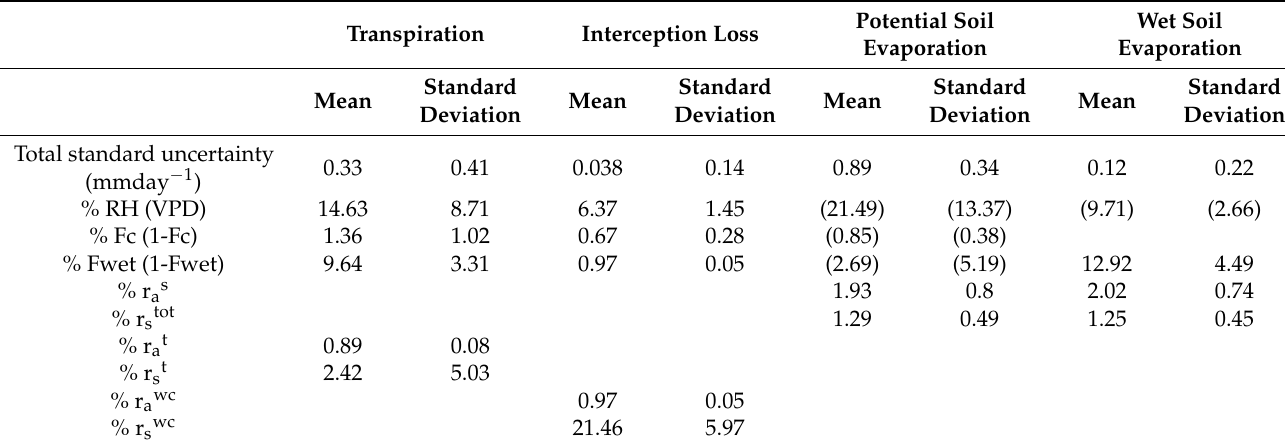
Table 6. Contribution of core and intermediate input variable relative uncertainties to each component of ET uncertainty for